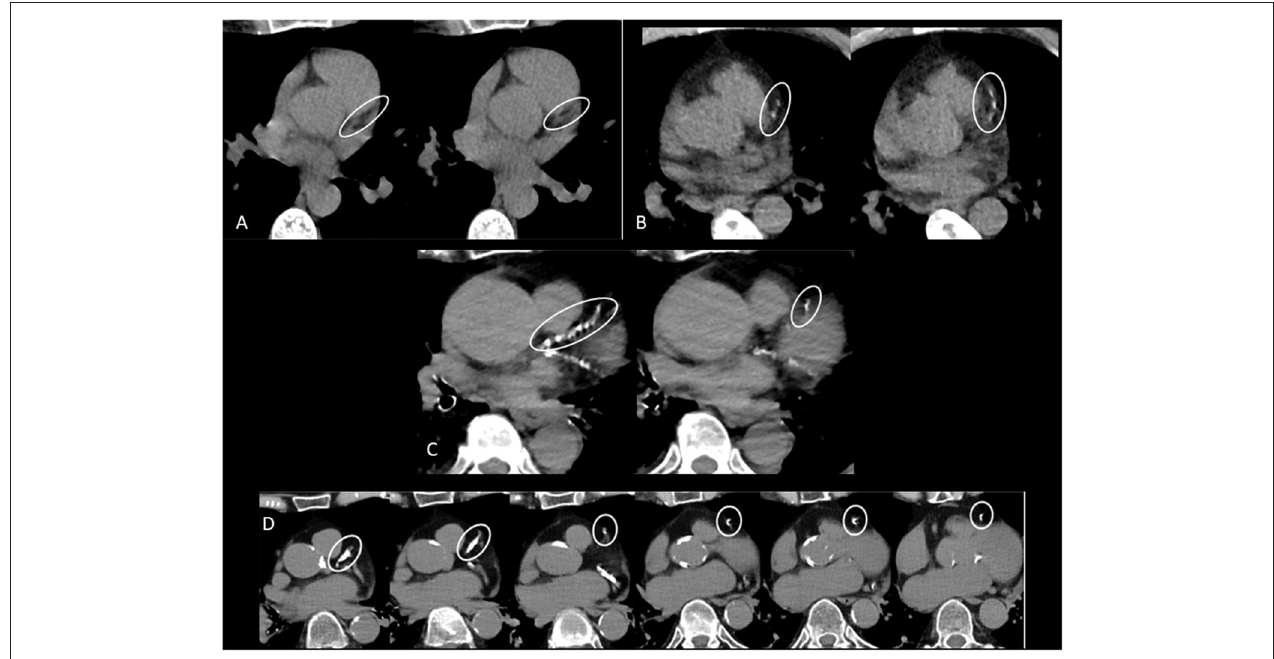
FIGURE 1 | (A) CAC score zero in left anterior descending (LAD) coronary artery. (B) Mild CAC in LAD. (C) Moderate CAC in LAD. (D) Severe CAC in LAD.